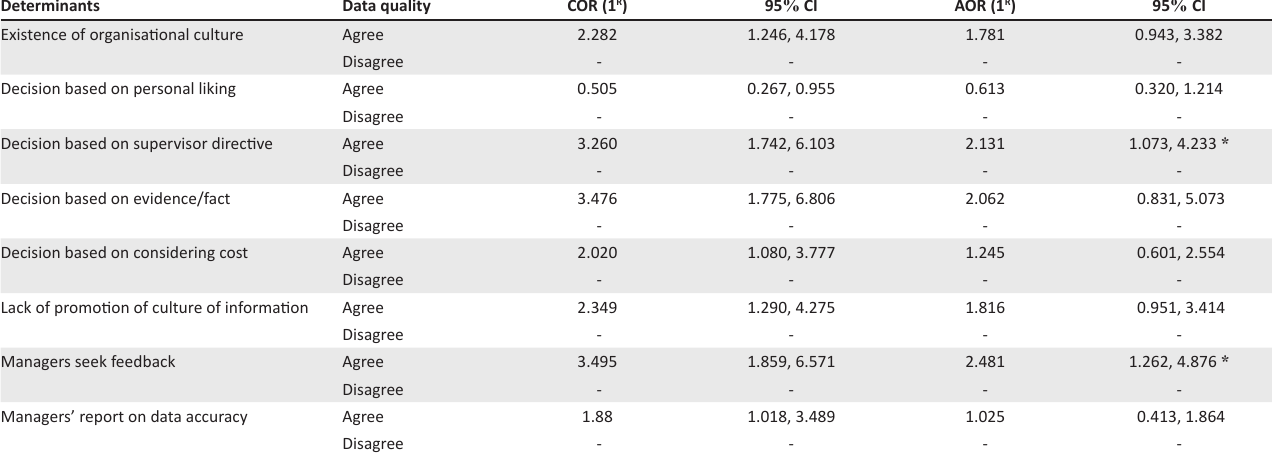
TABLE 6: Associated organisational and behavioural determinant characteristics for data quality in all governmental health facilities in Dire Dawa Administration, April 2013. Determinants Data quality Existence of organisational culture